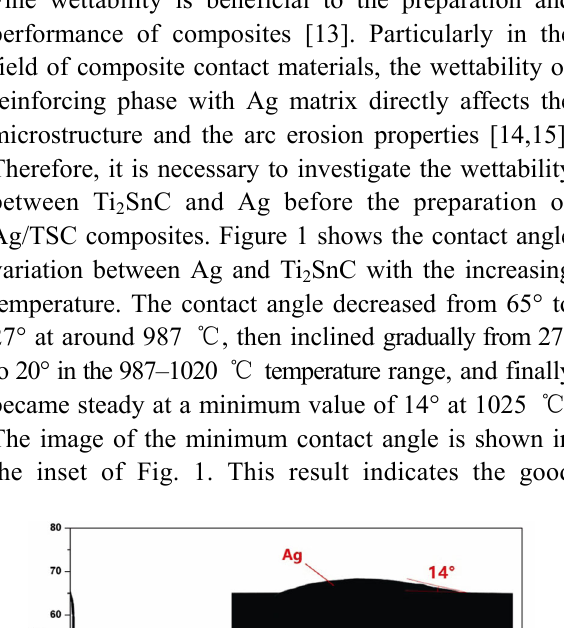
Table 2 Experimental parameters of the electrical